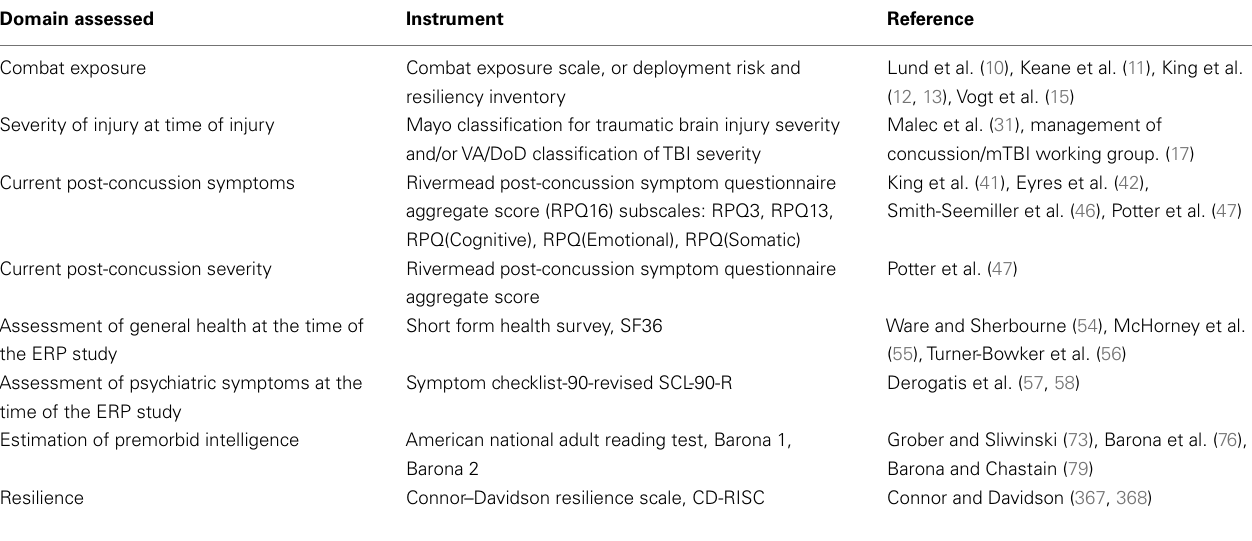
Table 15 | Instruments recommended for all studies of traumatic brain injury.